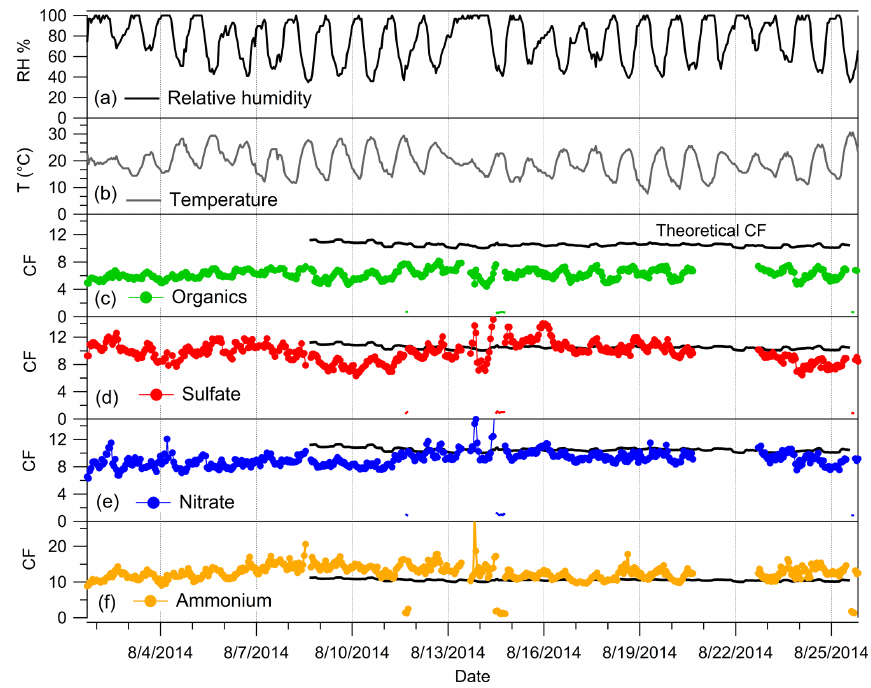
Figure 7. Ambient measurements at ARI showing ambient relative humidity (a) , ambient temperature (b) and measured CFs for organics (c) , sulfate (d) , nitrate (e) and ammonium (f) . The theoretical CF is shown with the black line in (c) – (f)